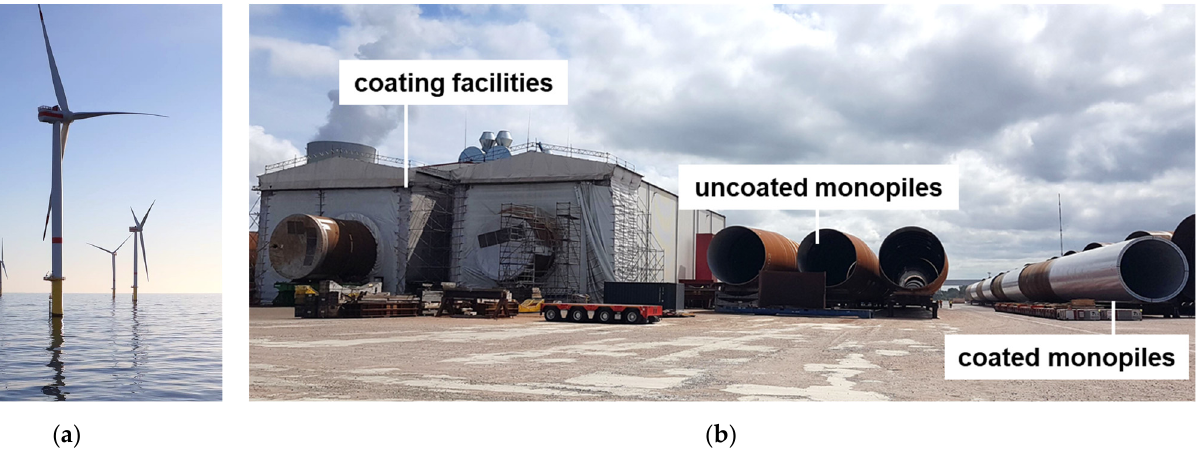
Figure 1. ( a ) Offshore wind turbines; ( b ) Facility for thermal spraying of offshore foundations as well as uncoated and coated monopiles.